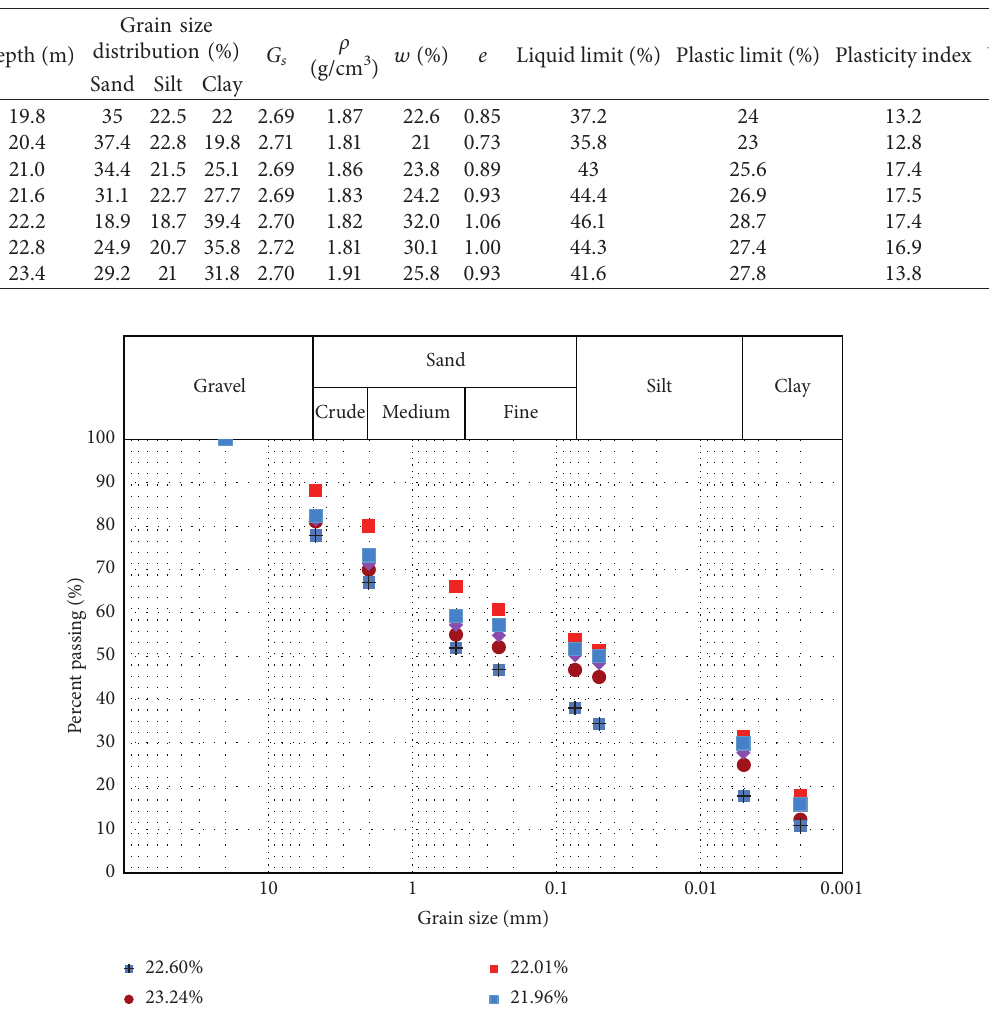
Table 1: Index properties of the CDG soil.